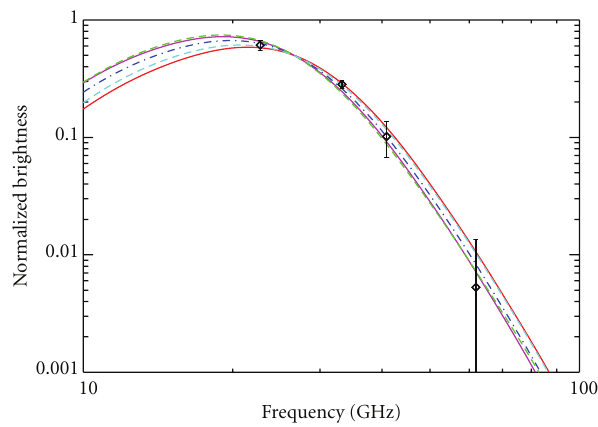
Figure 6: Comparison between data (diamonds and error bars) and di ff erent SpDust models. Red: n H = 0 . 25 cm − 3 T = 6000K, x = 0 . 1, χ = 1; magenta: same as red with x H n = 0 . 30 cm − 3 T = 6000K, x H 0 . 40cm − 3 T = 6000K, x H = 0 . 001, χ = 1; cyan: same as blue with χ = 0 .